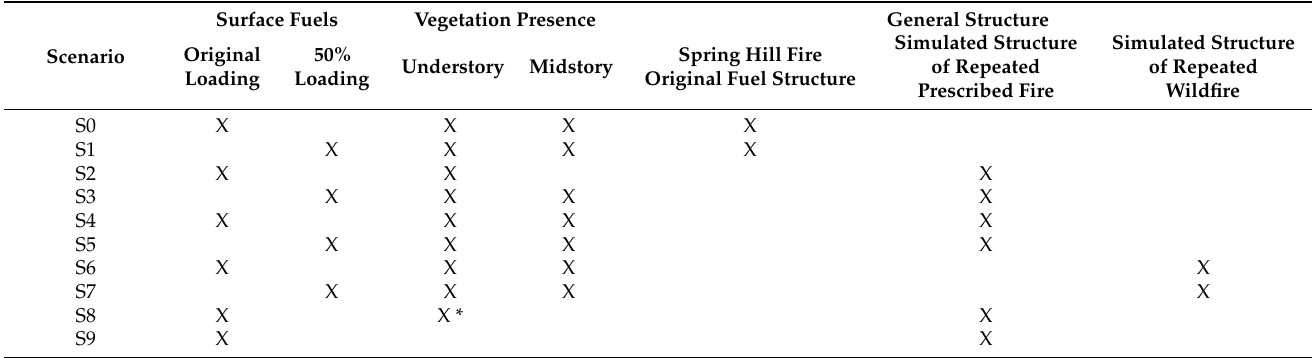
Table 2. Surface and canopy fuel parameter specifications for each model scenario.